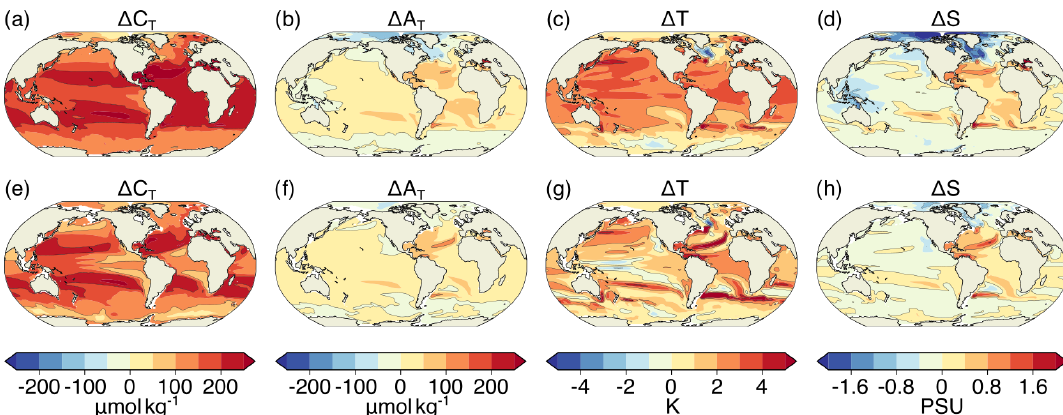
Figure A5. Simulated ensemble-mean changes in mean C T (a, e) , A T (b, f) , T (c, g) , and S (d, h) from the preindustrial period to 2081– 2100 following the RCP8.5 scenario. Shown are changes for (a–d) the surface and (e–h) at 200m. The black contours highlight the pattern structures.